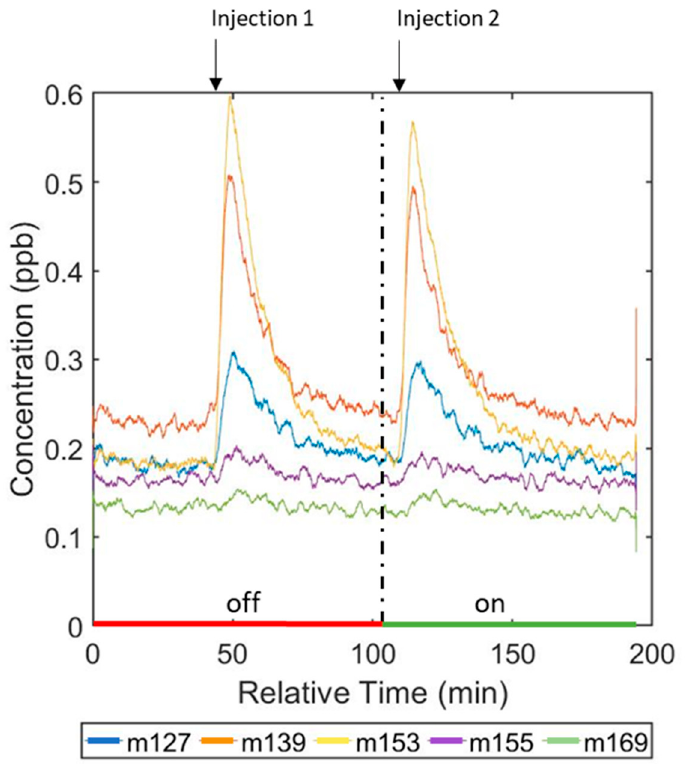
Figure A8. Evolution of the concentration of several VOCs of interest as potential byproducts of limonene oxidation as a function of the time during the perturbation test presented in Figure 12 (injection of limonene) when the air cleaner was off and when the air cleaner was on.